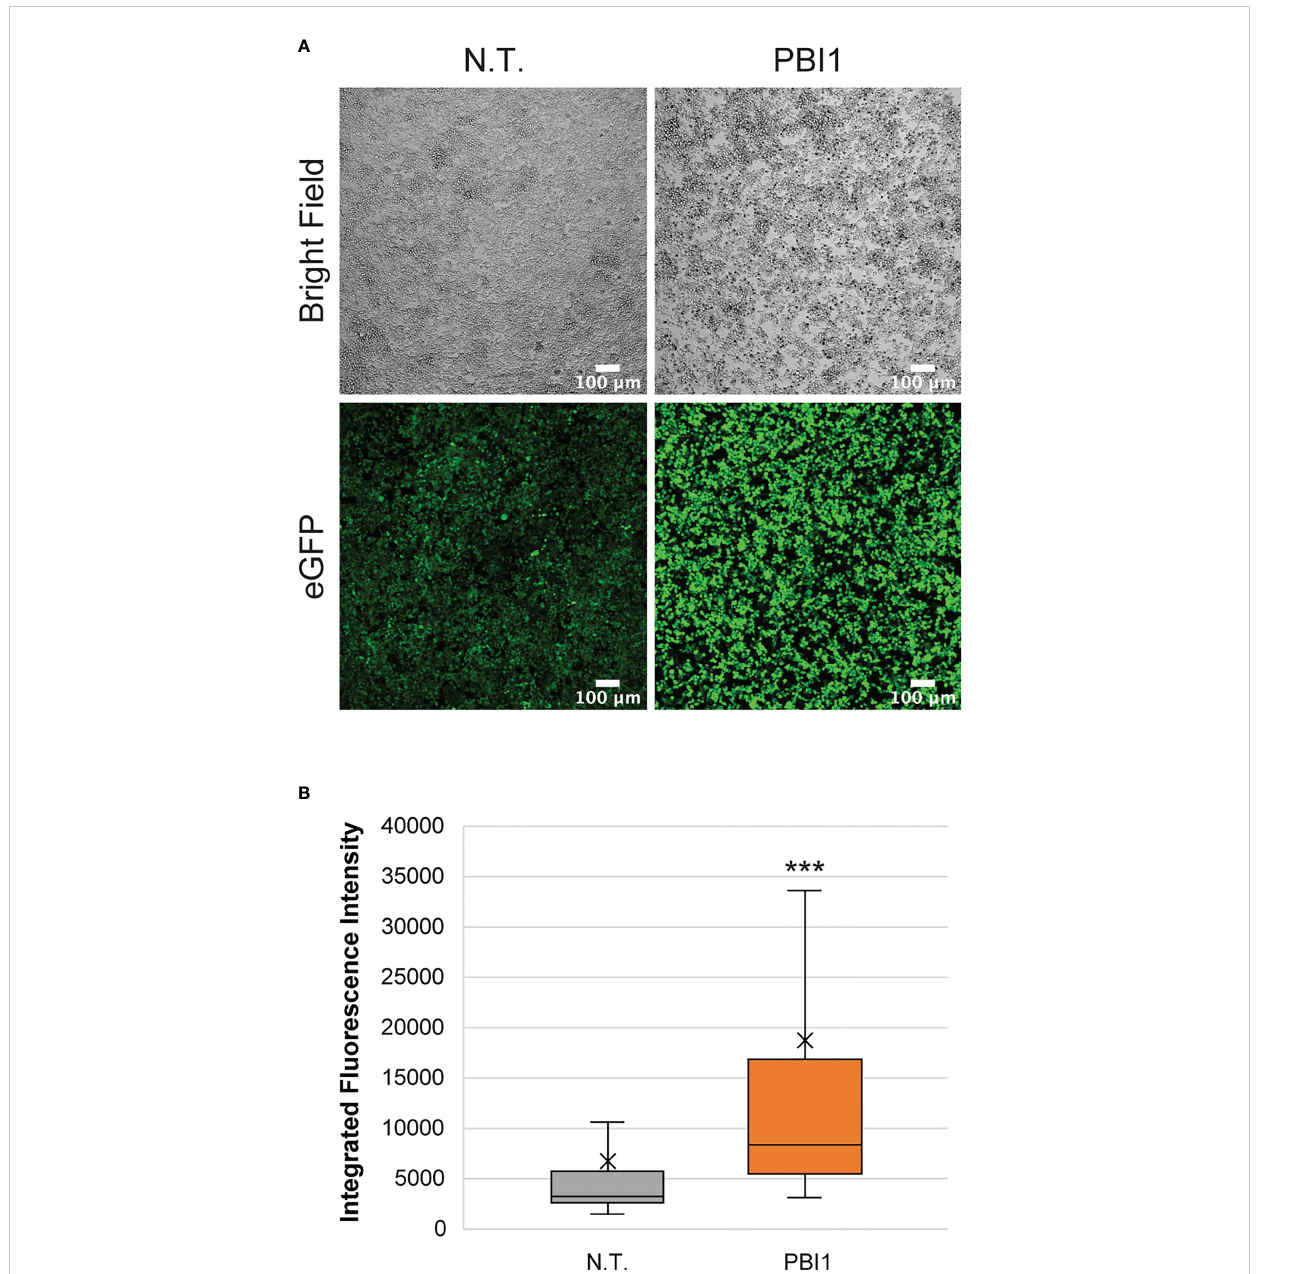
FIGURE 4 Effects of PBI1 on RAW:iNos-eGFP cells. (A) Confocal images showing changes in fl uorescence following PBI1 treatment, which results in activation of macrophages and greater levels of iNos. Scale bars represent 100 µm. (B) Quanti fi cation of fl uorescence intensity from images in (A) . The “ x ” in the box represents the mean; the bottom and top lines of the box represent the median of the bottom half (1st quartile) and median of the top half (3rd quartile), respectively; the line in the middle of the box represents the median; the whiskers extend from the ends of the box to the minimum value and maximum value. Error bars represent standard error. Student T-test was performed versus N.T. (p<0.001 = ***). N.T.=non-treated cells, eGFP=enhanced green fl uorescent